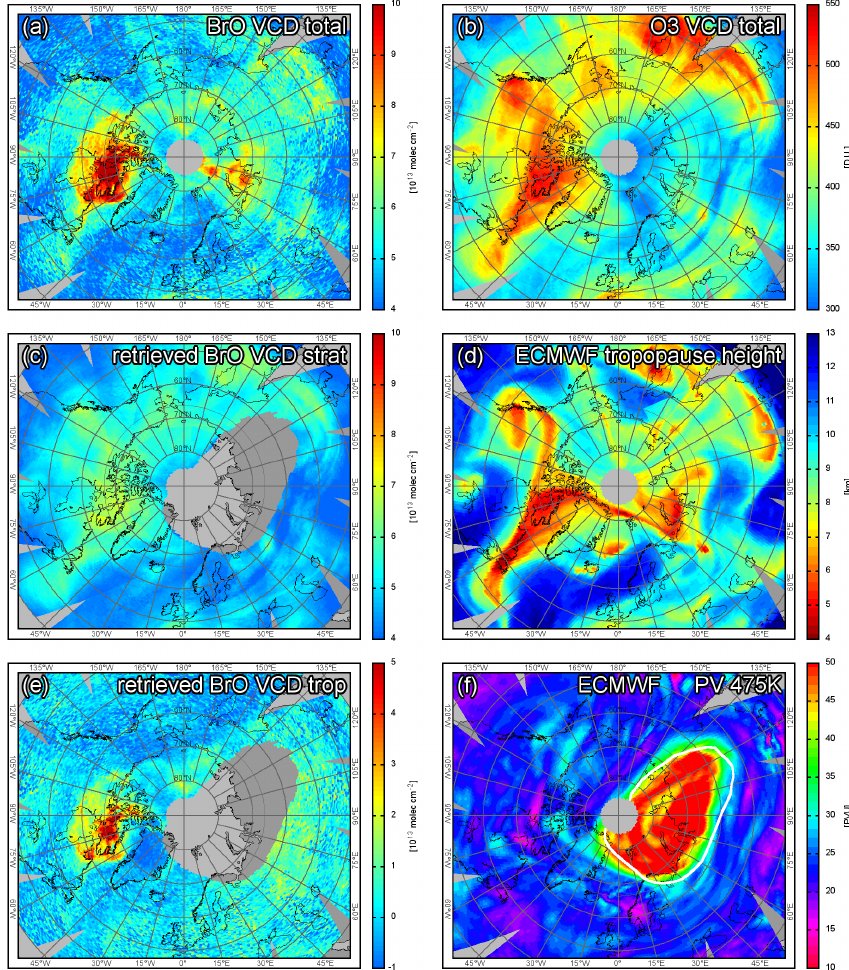
Fig. 2. Same as in Fig. 1, but for 1 April 2007. The white contour in (f) marks the 75PVU-isoline at the 550K isentrope. The decomposition into stratospheric and tropospheric column fails within the polar vortex, because there is no clear correlation between O 3 VCD and the tropopause height (d) any